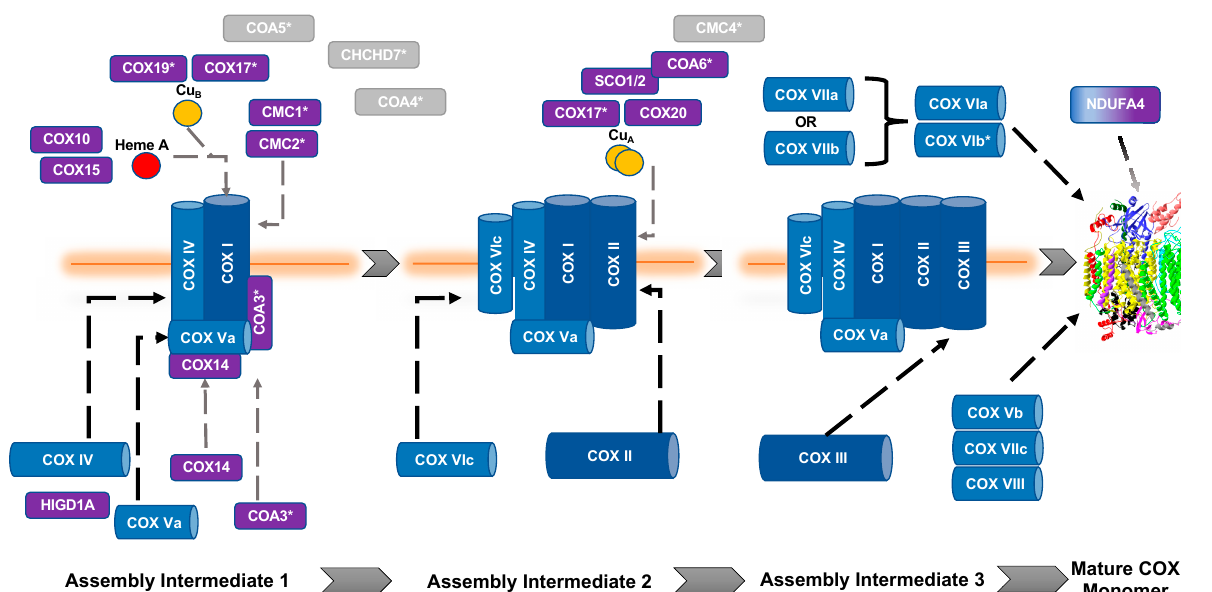
Figure 1. Assembly of cytochrome c oxidase. The assembly of COX is thought to be both modular and linear. Dark blue, mitochondrial encoded COX core subunits; light blue, nuclear encoded COX subunit; purple, assembly factors; gray, unknown function. *, Twin CX 9 C protein. Gray dashed lines represent assembly factor interactions. Black dashed lines represent subunit assembly.